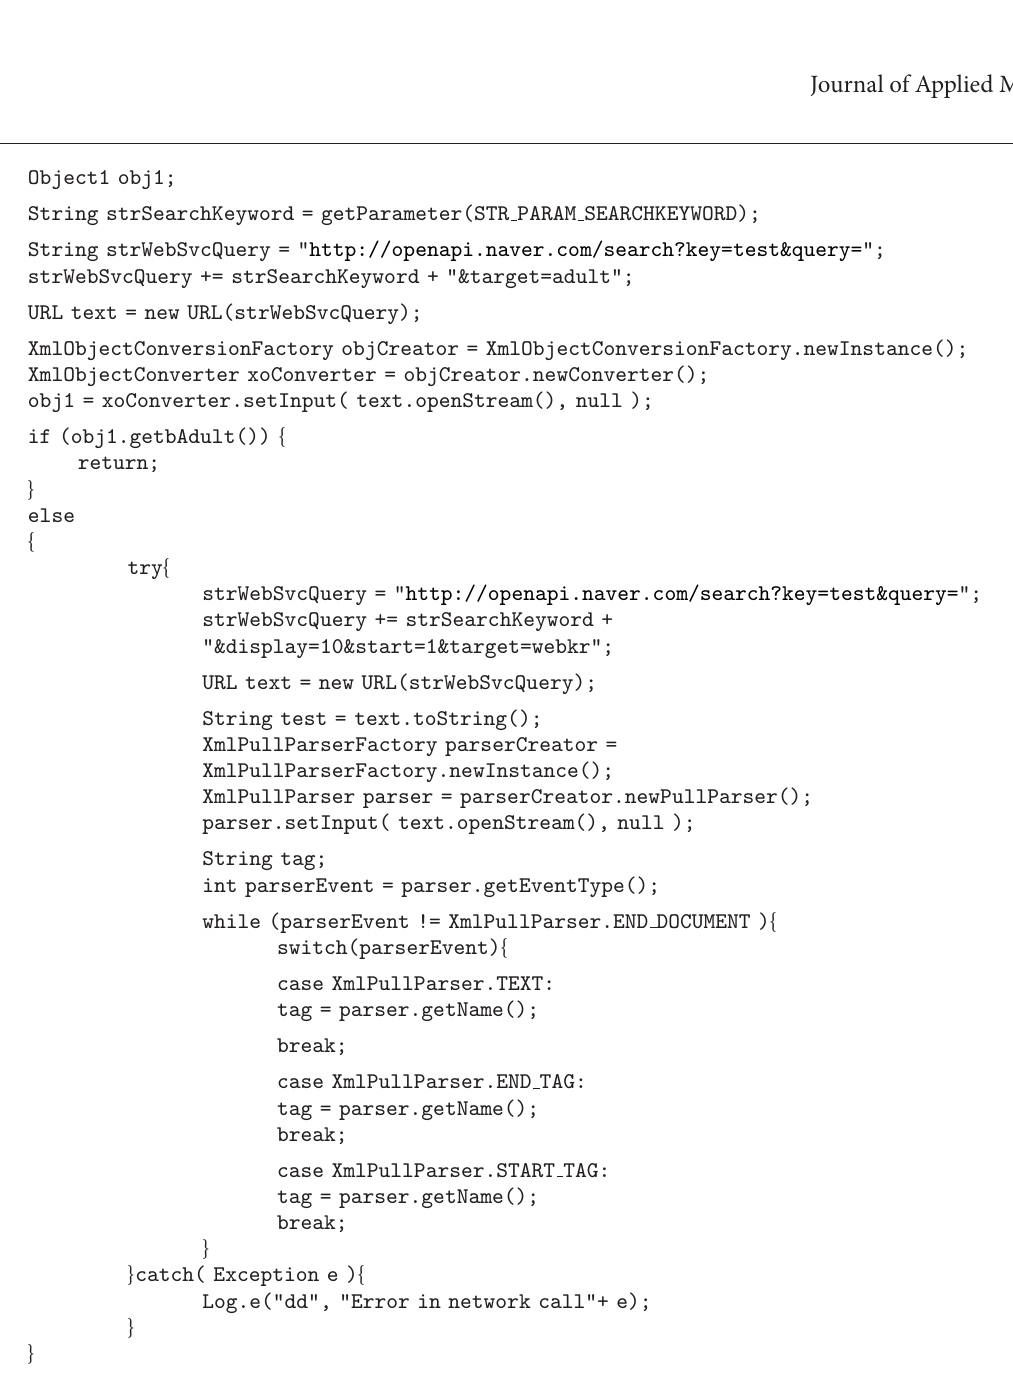
Algorithm 1: Open API